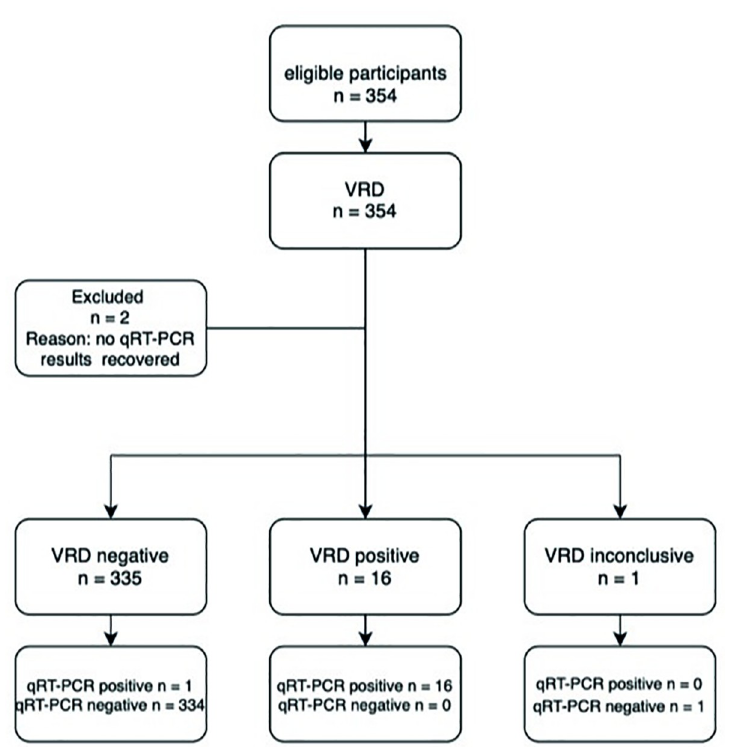
Fig 1. Diagram for the flow of participants for part 1 of the study (prospective